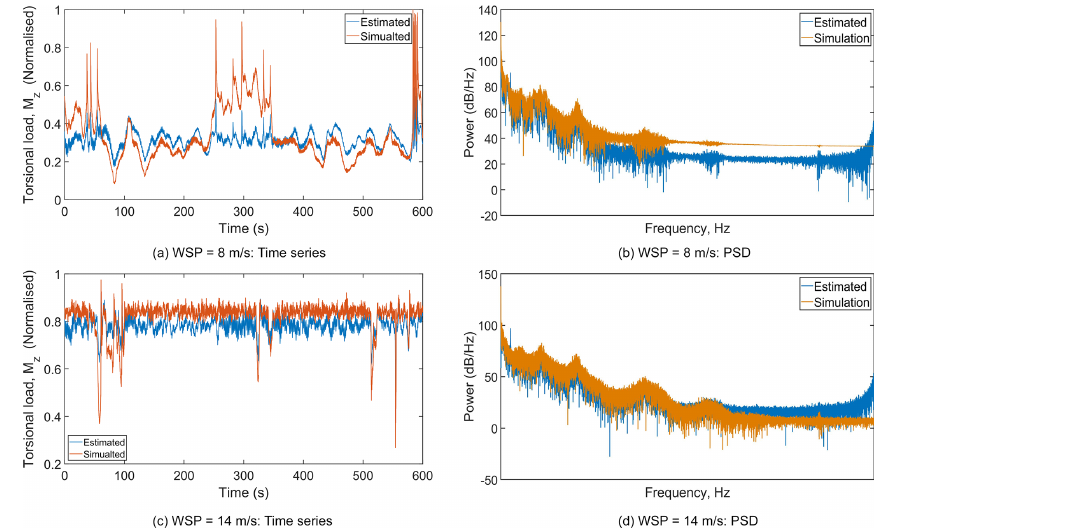
Figure 7. Comparison of reconstructed time series and power spectral density (PSD) of the torsional load for two different mean wind speeds.